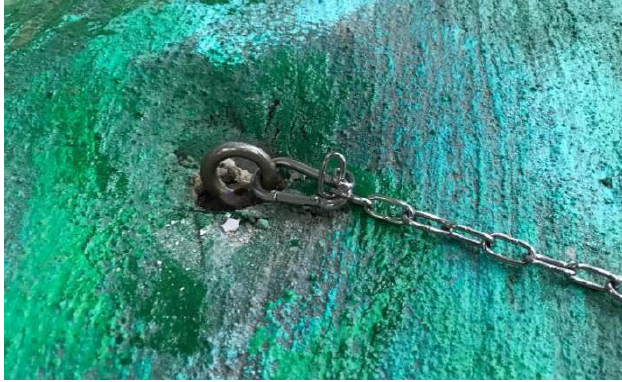
Figure 19. Anchorage point on the reef.